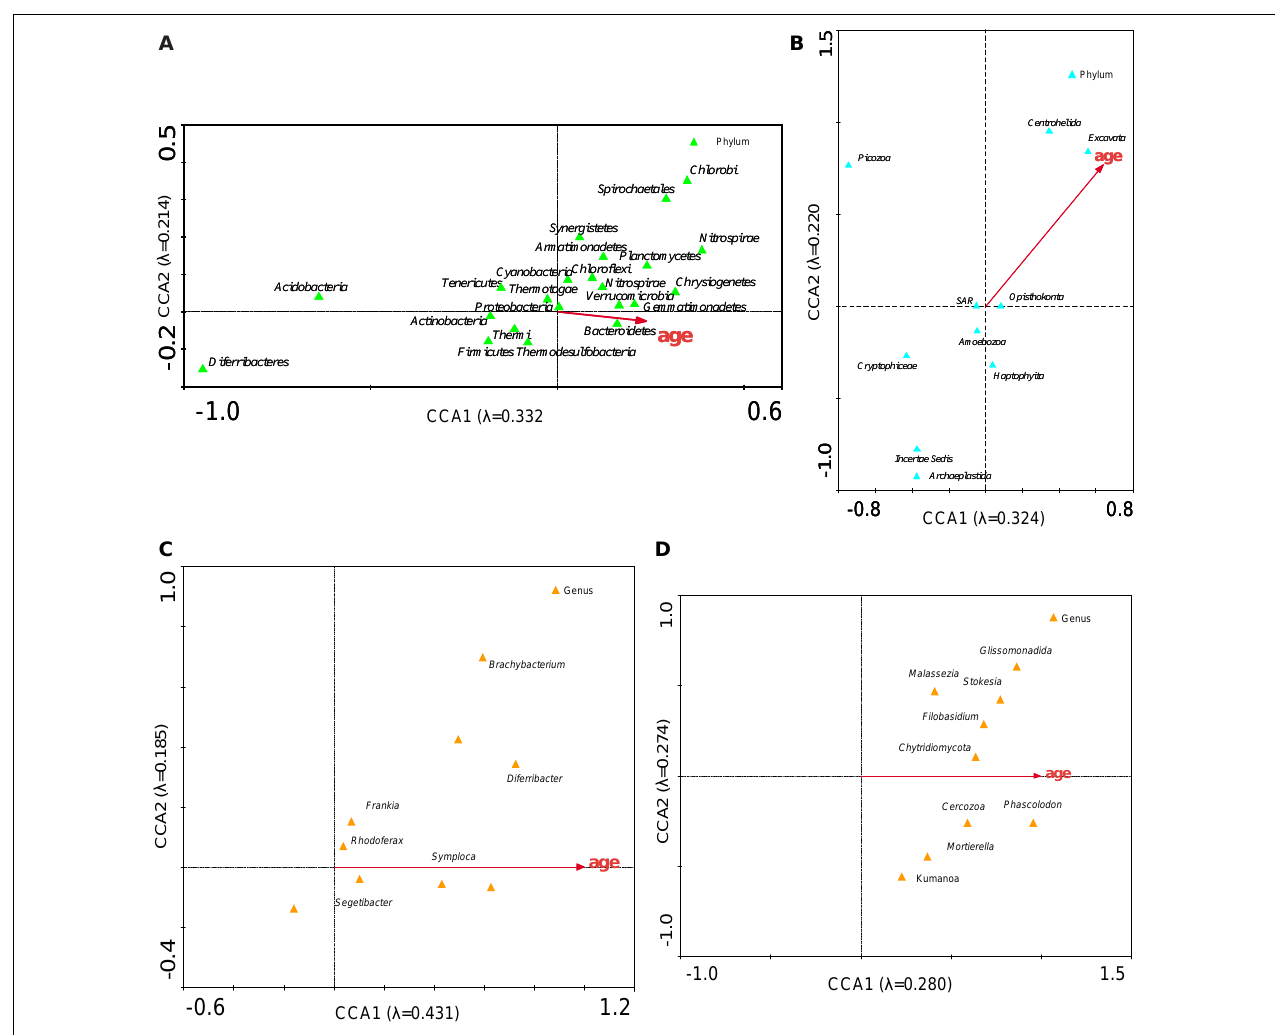
FIGURE 6 | CCA of the microbial groups with respect to age. Analysis of (A) bacterial phyla, (B) eukaryotic phyla, (C) bacterial genera, and (D) eukaryotic genera with respect to the ice age. The diagram displays triangles that represent taxonomic groups and arrows that symbolize environmental variables. The axes are scaled in standard deviation units. Correlations between microbial community and age are represented in axes.